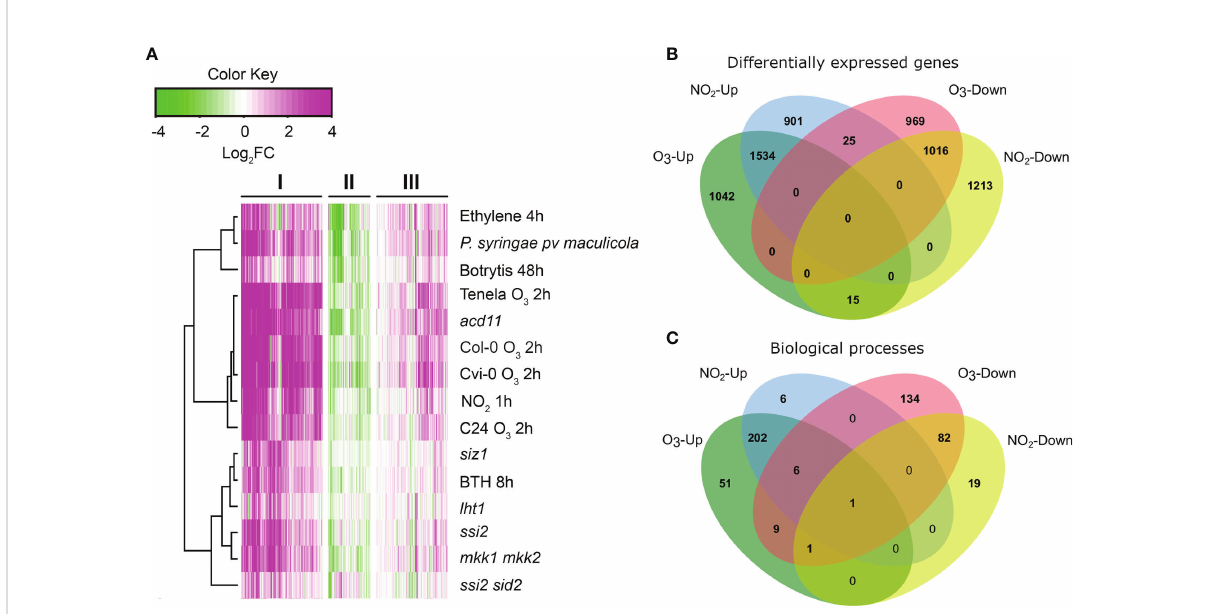
FIGURE 1 Comparison of O 3 and NO 2 transcriptional pro fi les. (A) Bayesian hierarchical clustering of genes from the gene ontology category cell death. Datasets were selected from NO 2 and O 3 treatments, pathogen and hormone treatments, and lesion mimic mutants that develop PCD lesions (see Supplementary Table 2 for more details). Values are log 2 -transformed fold changes in gene expression. Magenta and green indicate increased and decreased (respectively) gene expression compared to untreated or wild type control plants. (B) Comparison of differentially expressed genes after O 3 2 h and NO 2 1 h (see also Supplementary Table S5). (C) Overlap in signi fi cantly enriched GO Biological processes between